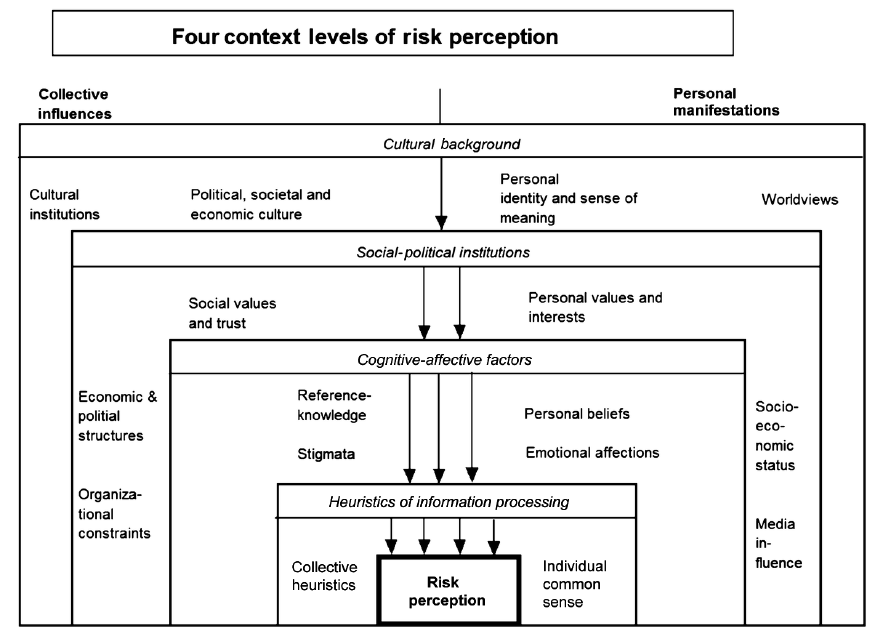
Figure 1. Levels of risk perception (Renn,